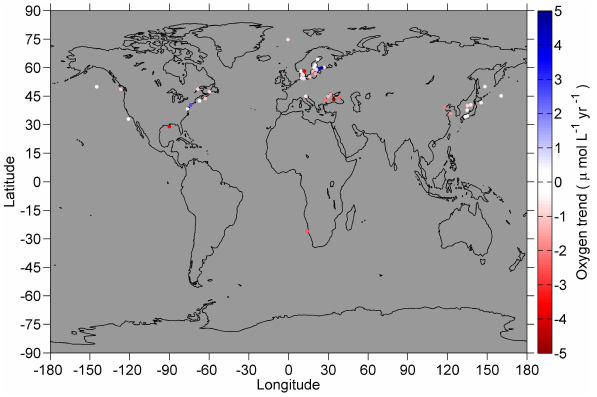
Fig. 6. Histogram of oxygen concentration trends calculated from published oxygen time series (Table 2) shorter than or equal to 33 years (blue, N=51) or longer than 33 years (red,